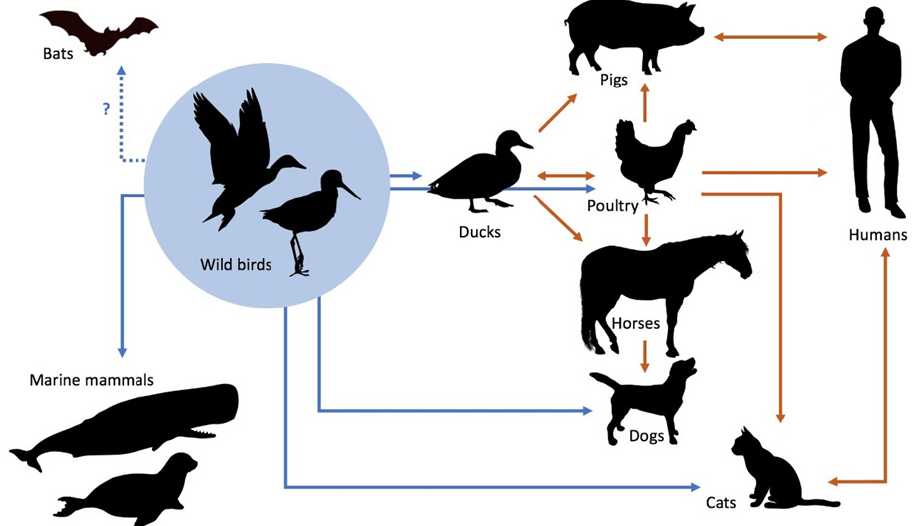
Figure 1. Emergence and transmission of influenza A viruses from aquatic wild bird reservoirs (adapted from [1]) .